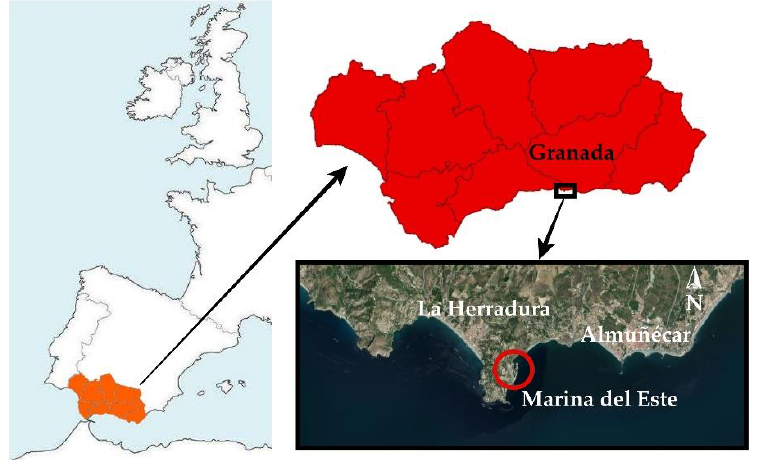
Figure 1. Location